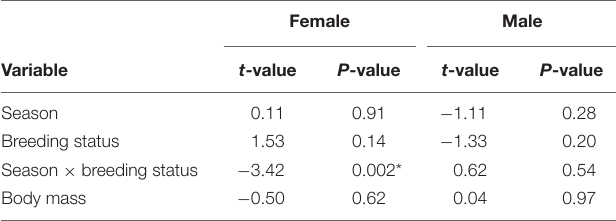
TABLE 4 | The statistical outputs of the effects of the season (non-breeding period/wet season vs. breeding period/dry season) and breeding status (breeding vs. non-breeding), their two-way interactions and body mass on the oxidative stress index (OSI) of 31 female and 35 male highveld mole-rats ( Cryptomys hottentotus pretoriae ).